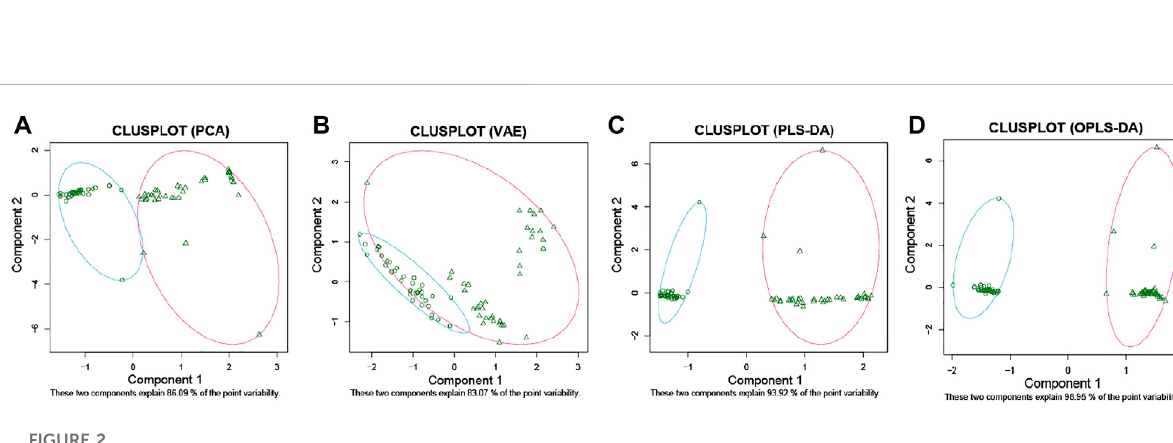
Frontiers in Molecular